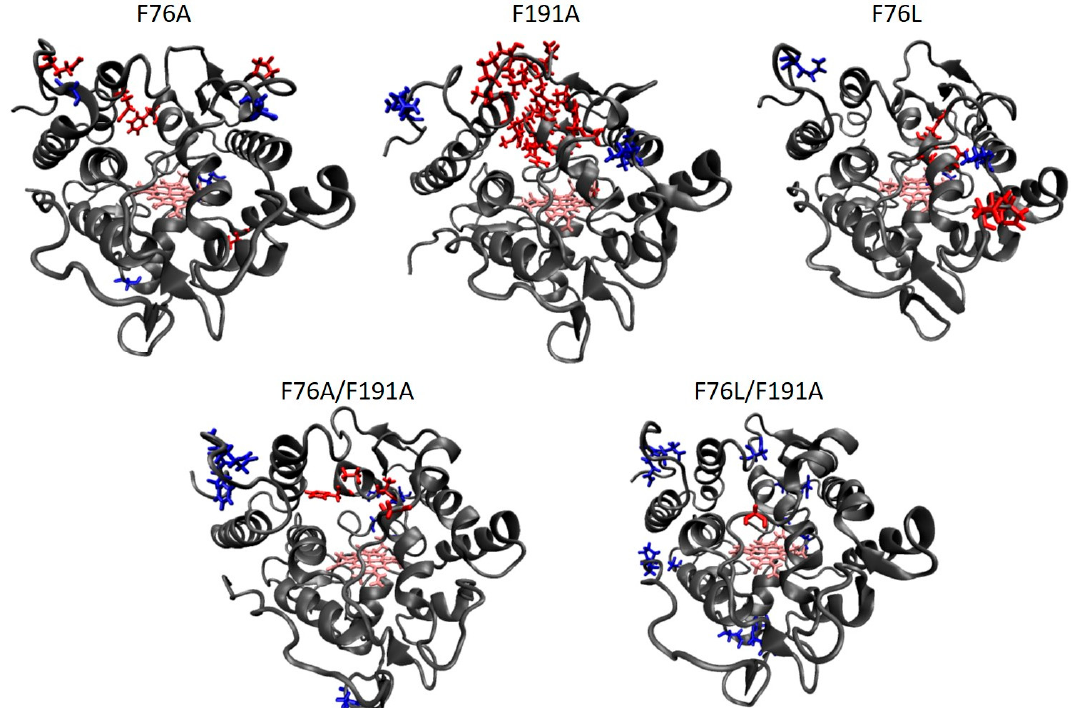
Figure 3. Protein models of the PaDa-I variants showing the localization of the residues with increased (red) and decreased (blue) mobility. The heme group is shown in pink and the protein backbone in a grey ribbon. For the details of residue identity, see Table S2 (Supplementary Materials).